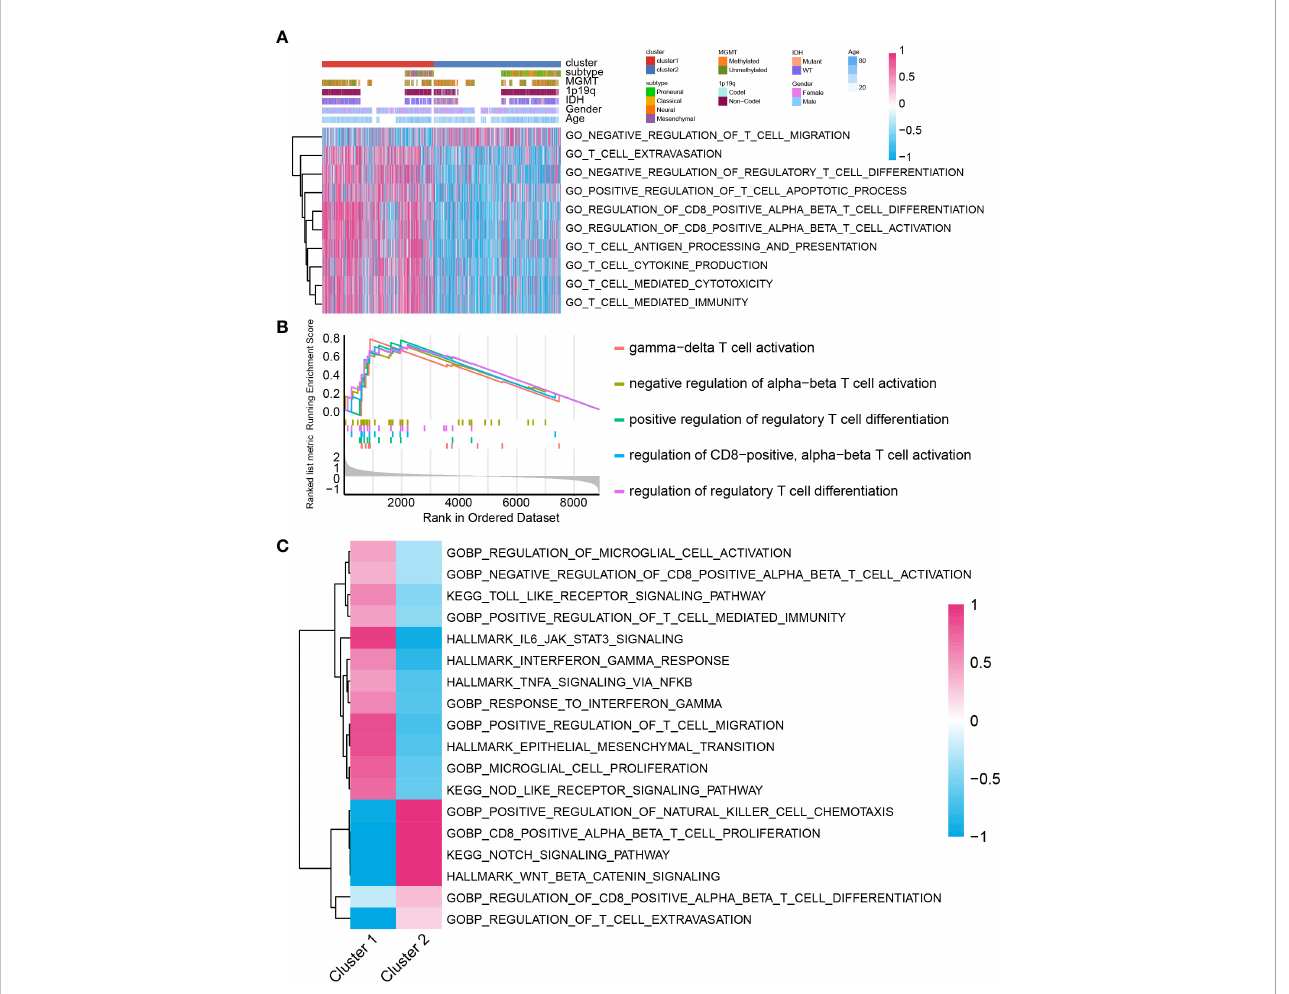
FIGURE 4 The biofunction prediction based on the cluster model in the GBM meta cohort. Biofunction prediction based on GSVA (A) and GSEA (B) . (C) GSEA enrichment based on single cell RNA-seq